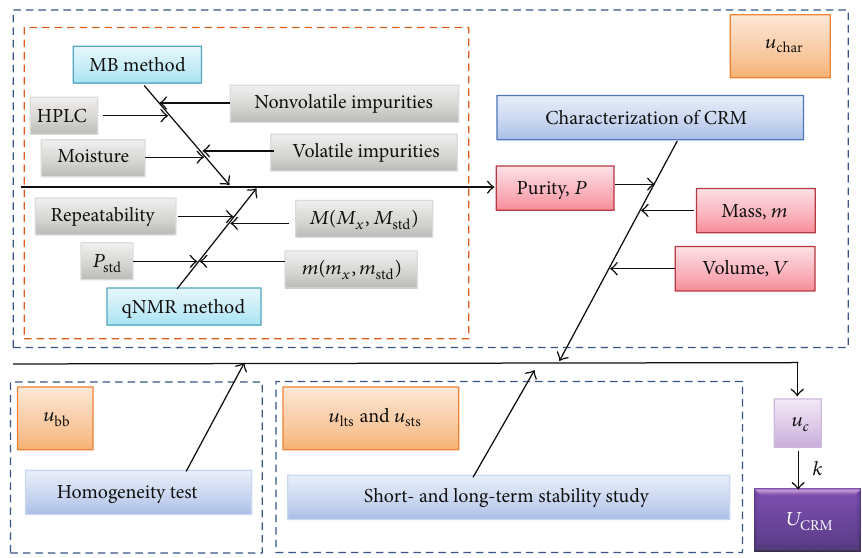
Figure 4: Uncertainty sources in the development process of chloramphenicol in methanol CRM.